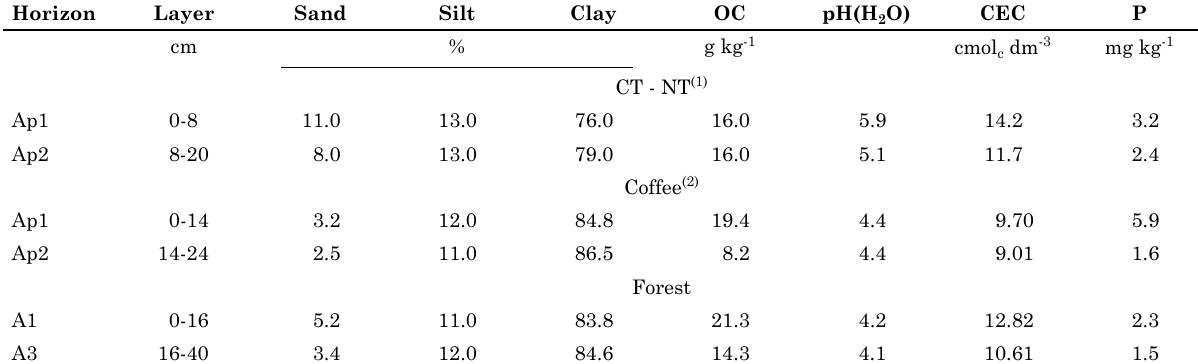
Table 1. Initial values of soil physical and chemical properties horizon layer Sand